Question: Does the plotted quantity increase or decrease?
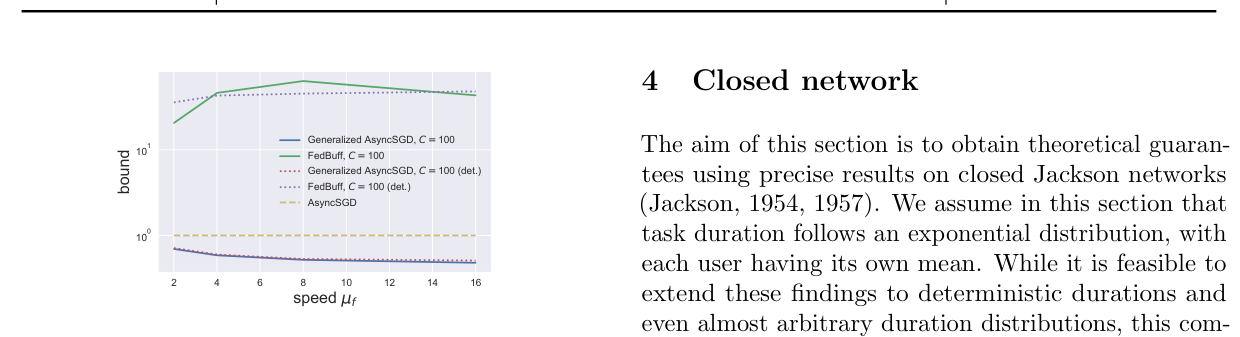
Answer: increasing